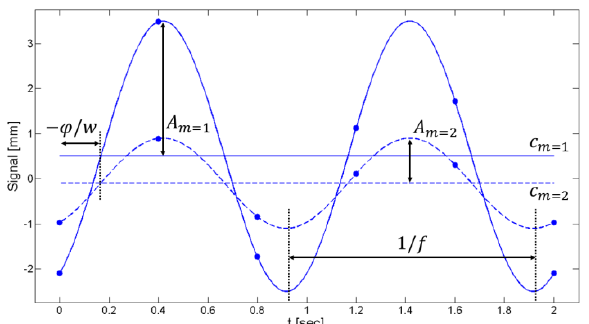
Figure 3. Example of two features with different amplitudes and mean signal values, but common phase and loading frequency (1 Hz) sampled at 2.5 Hz